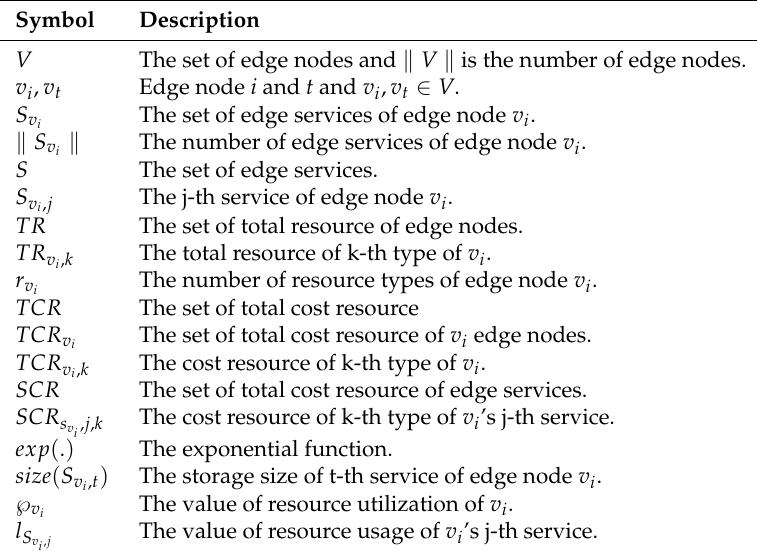
Table 1. Symbol descriptions for basic